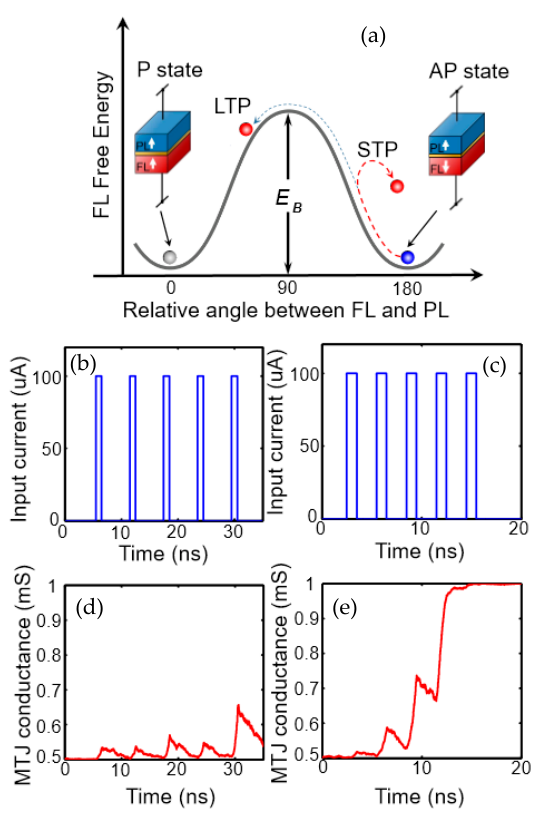
Figure 2. ( a ) Synaptic “learning” and “forgetting” with a mono-domain MTJ: The input stimuli frequency must be high enough to enable crossing the energy barrier separating to two stable states (STP and LTP, indicating short- and long-term plasticity). For ( b ) low input stimuli frequencies, ( d ) switching is not possible, while for ( c ) higher input frequencies, ( e ) switching is enables. Reprinted with permission from [22]. Copyright (2018) by AIP Publishing.